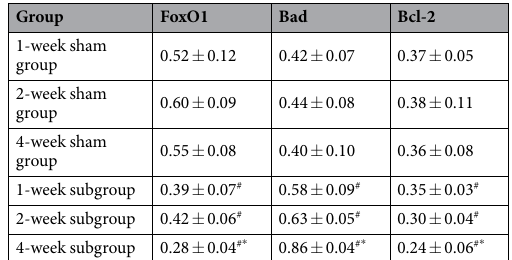
Table 4. FoxO1, Bad, and Bcl-2 protein expression in the rat CTEPH model. Note: # P < 0.05 , compared to sham group within the same subgroup. * P < 0.05 , compared to 1- and 2-week experimental